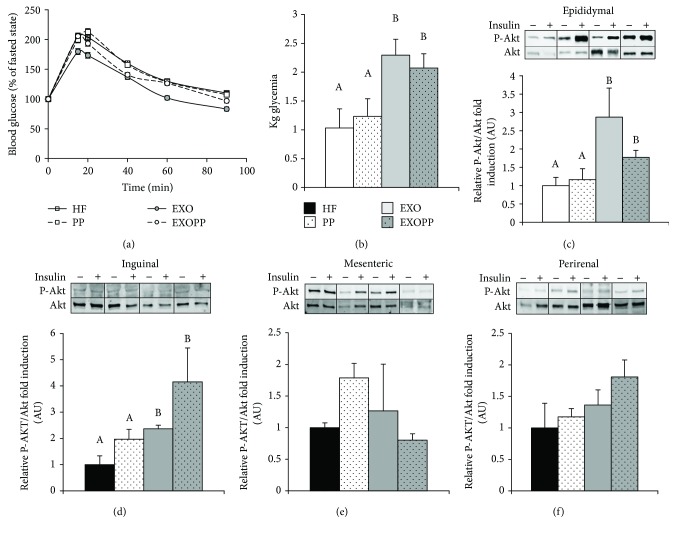
Measure of whole-body glucose homeostasis and adipose tissue insulin sensitivity. (a) Glycaemia expressed in percentage of fasted blood glucose and (b) glucose disposal (Kg) calculated from GTT. Data are expressed as mean ± SEM with n = 8–10 rats per group. P-Akt and Akt expression levels were measured by immunoblotting after insulin stimulation in epididymal (c), inguinal (d), mesenteric (e), and perirenal (f) fat stores. A representative blot is shown for each adipose tissue depot. Quantified values are presented as P-Akt/Akt fold induction relative to HF group's values, which were set at 1. Data are expressed as mean ± SEM with n = 5 rats per group. Bars not sharing a common letter are significantly different at p < 0.05.